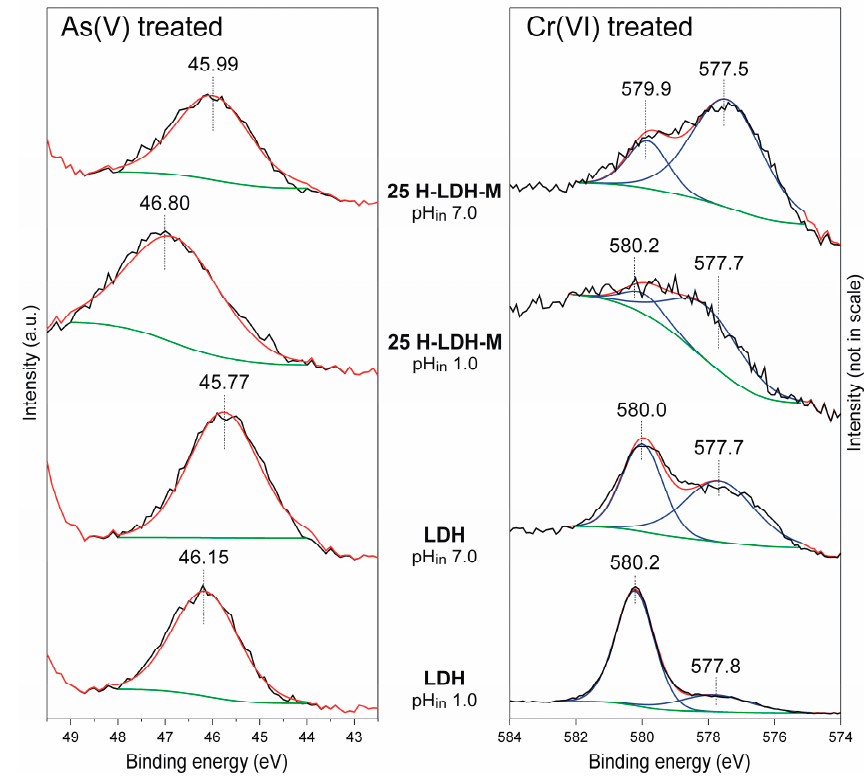
Figure 9. XPS spectra (As 3d and Cr 2p 3/2 ) of LDH and 25 H-LDH-P after reaction with As(V) and Cr(VI). Initial concentration (C in ) 5 mmol/L.